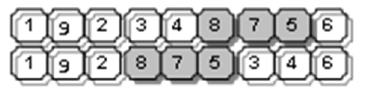
Figure 12. The DM procedure for selected position 4.